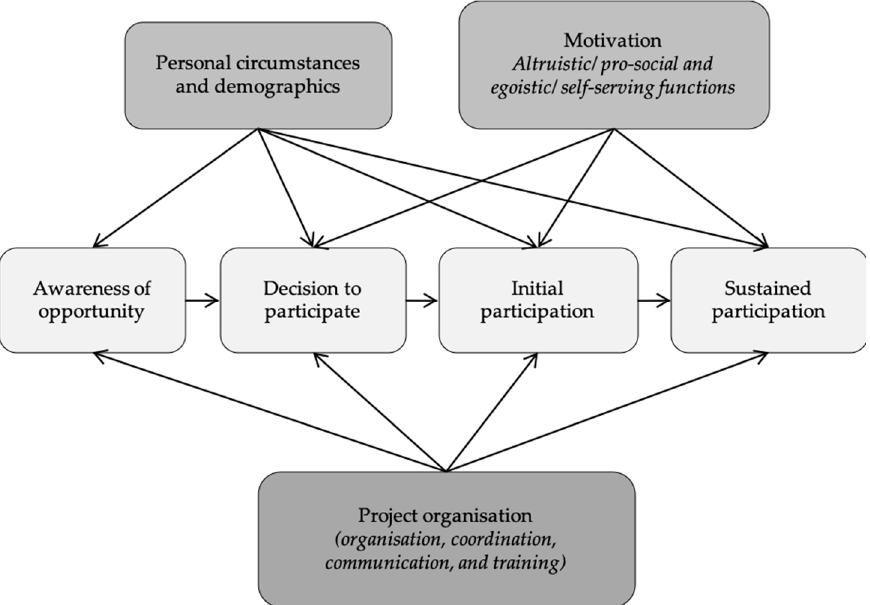
Figure 1. Model of Influence for participation in citizen science projects by Penner (2002) [17], adapted by and cited from West et al. (2016) in Geoghegan et al. (2016) [11]. Additions by Moczek, 2019 [18].